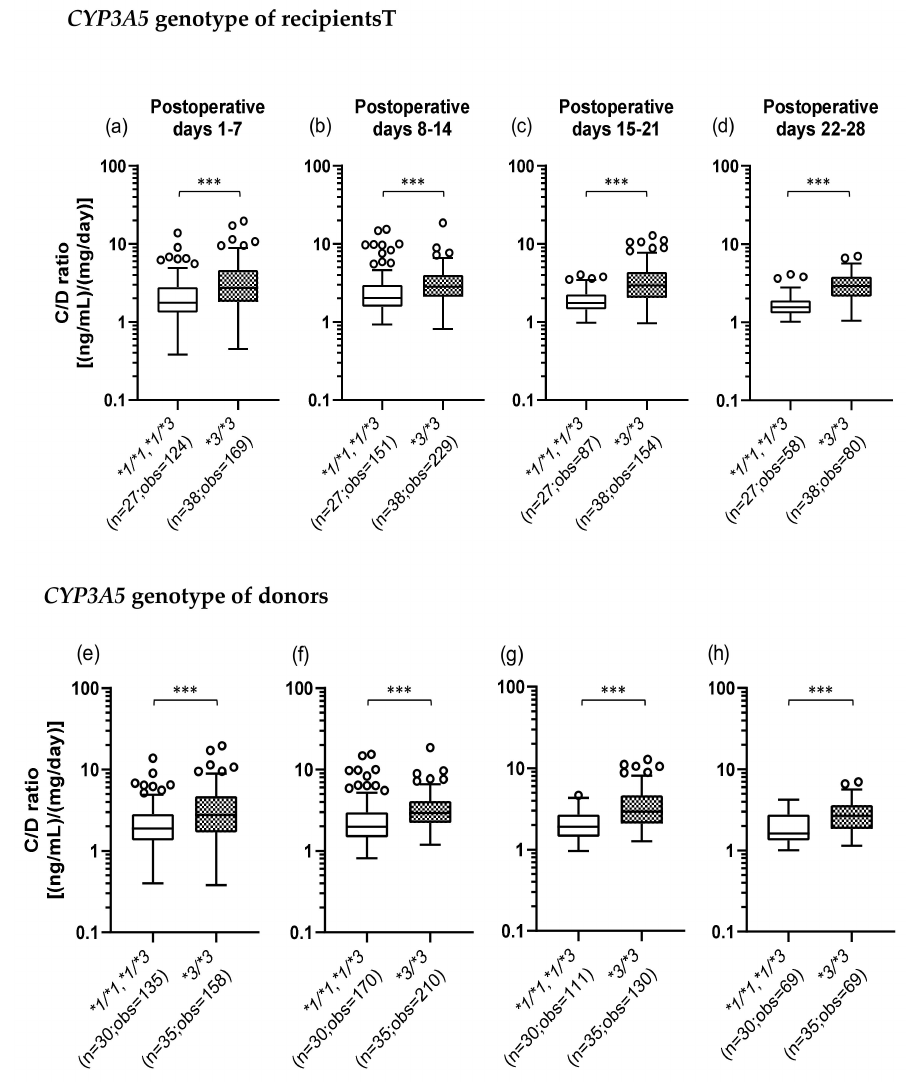
Figure 1. Influence of the recipient’s ( a – d ) or donor’s ( e – h ) CYP3A5 polymorphism on the concentration / dose (C / D) ratio of tacrolimus on postoperative days 1–28 after living-donor liver transplantation. The C / D ratios of tacrolimus were compared on days 1–7 (a, e), 8–14 (b, f), 15–21 (c, g), and 22–28 (d, h) after transplantation for each CYP3A5 genotype. The bar indicates the median tacrolimus C / D ratio for each group, and boxes represent the 25th and 75th percentiles of the data. The whiskers represent the lowest and highest values that fall within 1.5 times the interquartile range of the lower and upper quartiles, respectively. ***p < 0.001 between the groups. n, Number of patients; obs, number of observations i.e., number of tacrolimus